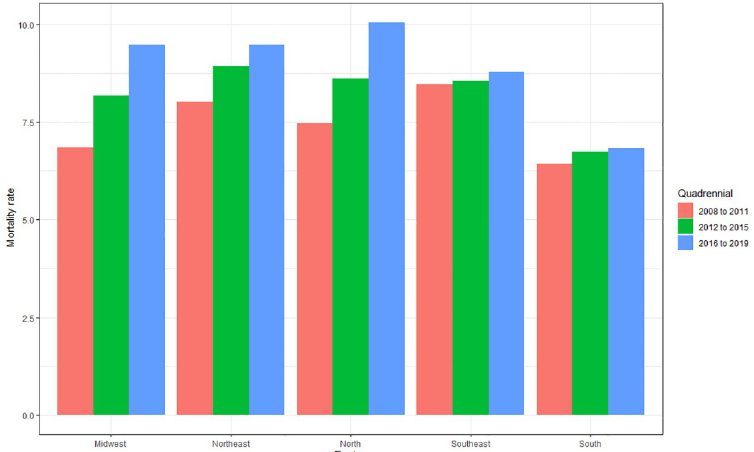
Fig 10. Average mortality rate from cardiovascular diseases according to region of residence and quadrennium (2008 to 2011; 2012 to 2015; 2016 to 2019). Source: Ministry of Health–Hospital Information System of the Unified Health System (SIH/SUS)